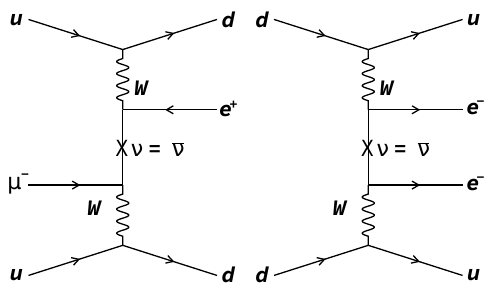
Figure 1. The tree-level diagram of µ − → e + ( left ) and 0 νββ ( right ) in a Majorana neutrino model. Benefiting from progress in detector technology and the feasibility of obtaining a large amount of target material, models involving LNV in general are more easily observable at 0 νββ experiments, such as KamLAND-Zen [7], than in µ − → e + searches. This is true for the case that a light Majorana neutrino mediates the LNV, where 0 νββ would be more easily measurable than µ − → e + . The effect on the 0 νββ and µ − → e + processes in a specific new physics model, for example, a heavy sterile neutrino model, is not very well studied. The “Black box theorem” [8–11] relates the Majorana neutrino mass to the amplitude of 0 νββ and any ∆ L = 2 processes even in the presence of new physics, showing that the occurrence of any ∆ L = 2 process, including µ − → e + , implies a nonzero Majorana neutrino mass. An enhancement or suppression of the rate of µ − → e + over 0 νββ was suggested